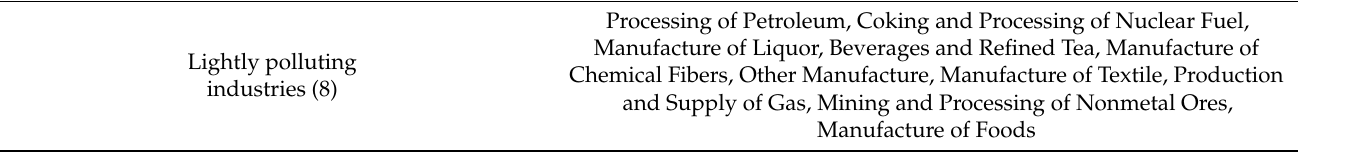
Figure 1. Division of polluted areas: border layer and non-border layer.